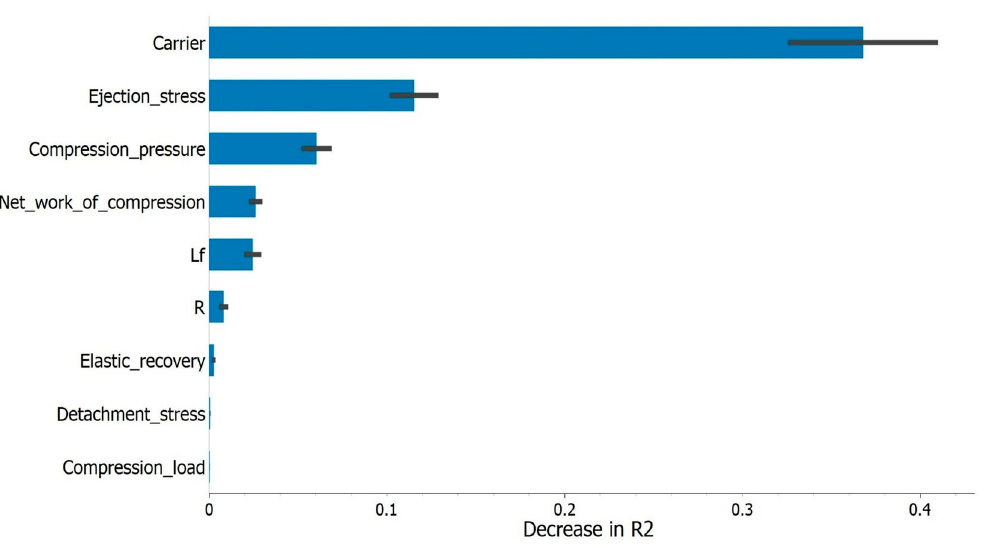
Figure 5. The influence of tested variables on regression model’s output (presented as the decrease in coefficient of determination that removing a variable would cause).